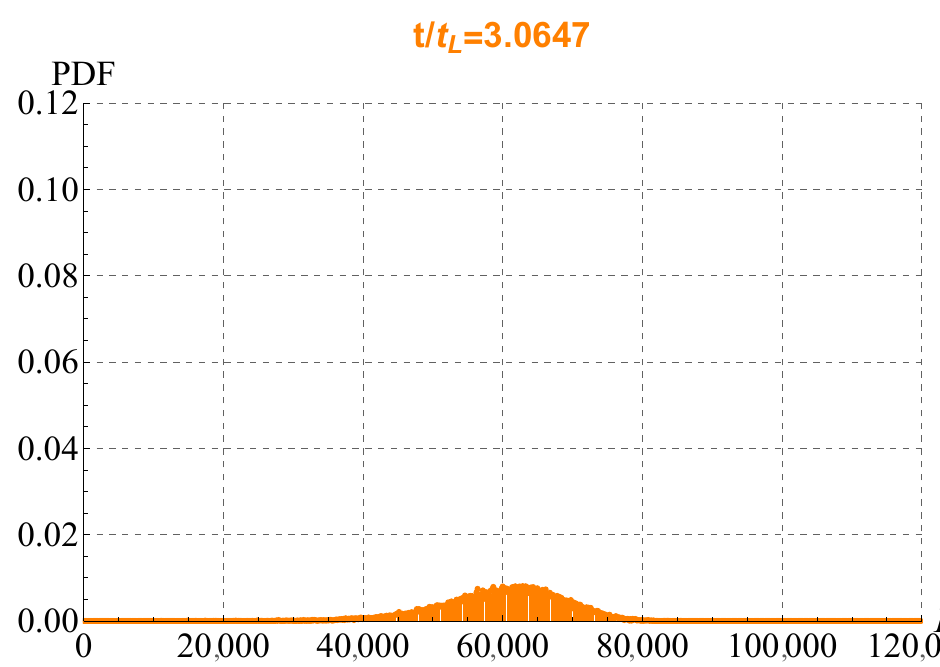
Figure 10. Probability density function (PDF), solution of Equation (36) for Italy, first wave of infection by SARS-CoV-2. Screenshoot at time ˆ t = 3.0647.